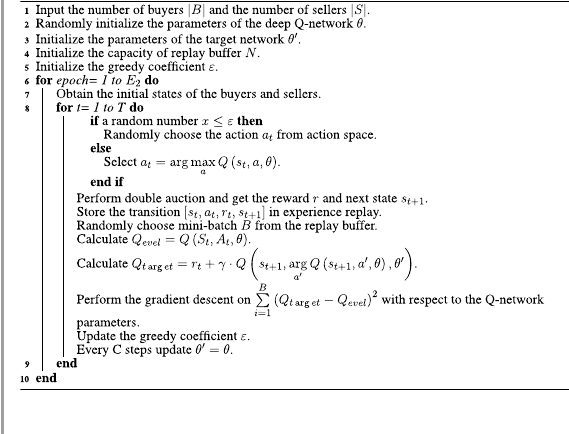
Algorithm 2. The training process of deep Q-learning algorithm in double